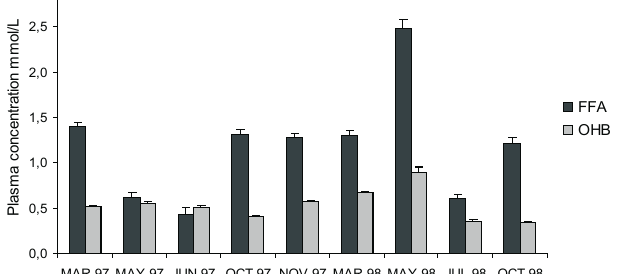
Fig. 4. Mean (SE) plasma concentrations of FFA and B-OHB of the Seiland reindeer herd in 1997 and 1998.